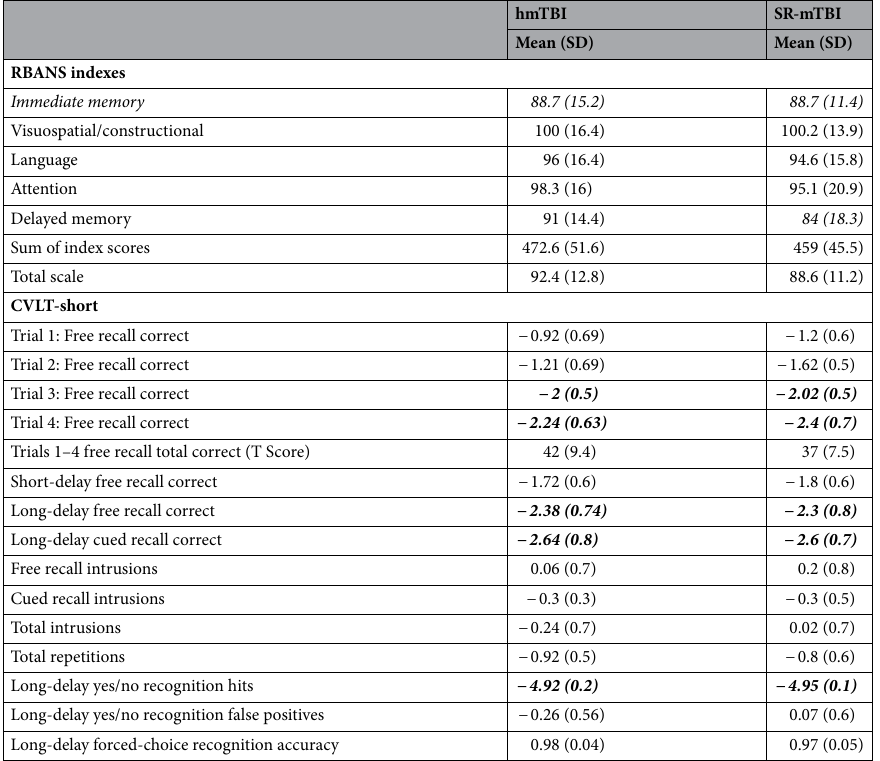
Table 2. Neuropsychological assessment data. All RBANS index score values were between 90 and 109 and normal. CVLT-Short standardized scores > 1.96 are considered impaired (bold italicized). hmTBI history of mTBI, SR-mTBI sports related